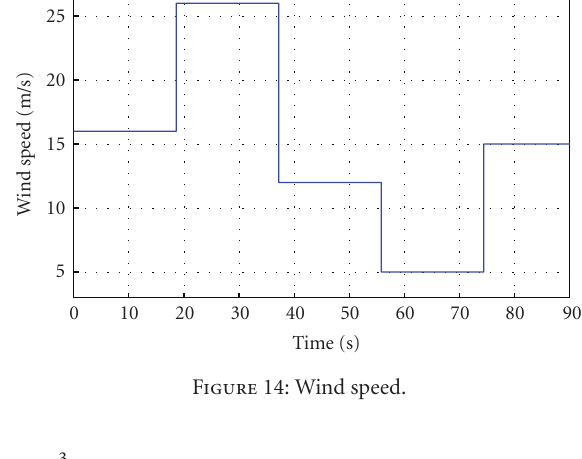
Figure 16: Per-unit wind turbine produced power.